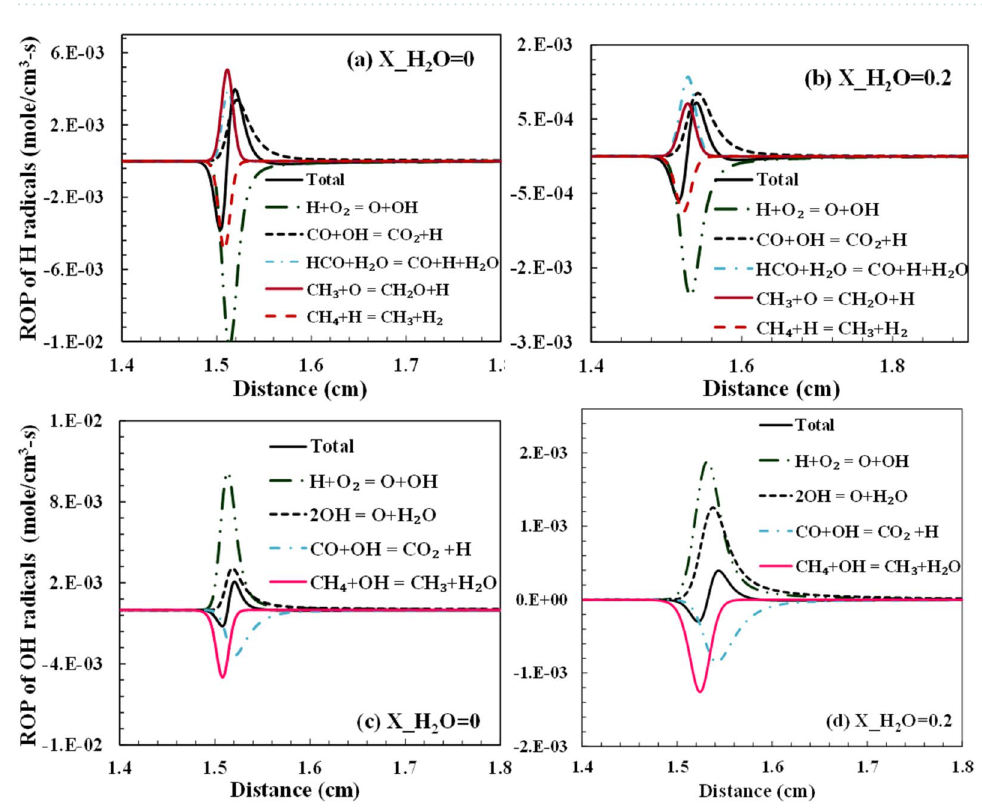
Figure 13. The net rate of production of ( a – b ) H and ( c – d ) OH radicals with 0% and 20% steam dilution using Aramco-3.0